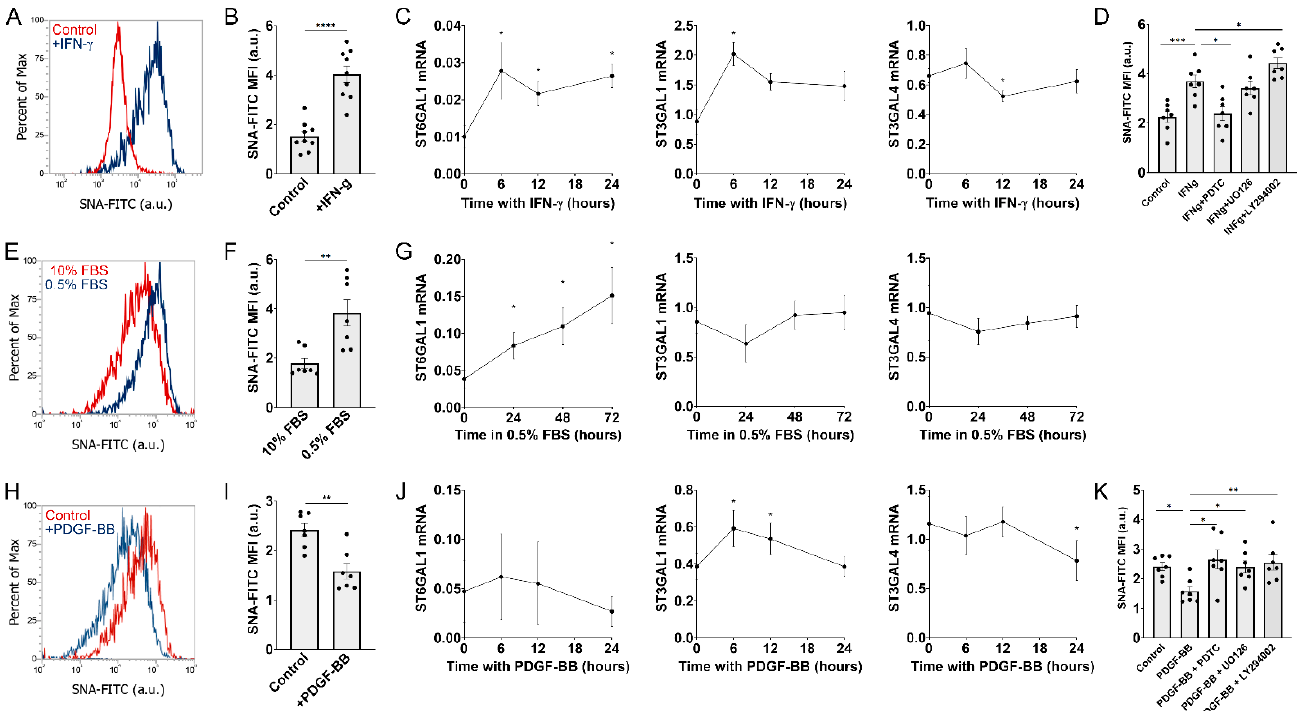
Figure 1. IFN- γ , 0.5%FBS and PDGF-BB modulate sialylations and expression of sialyltransferases. MSCs were cultured for 2 days with either IFN- γ (50 ng/mL), with low fetal bovine serum (0.5% FBS) or PDGF-BB (10 ng/mL) and stained using the lectin SNA, coupled to FITC. ( A , E , H ) show representative histogram plots, while ( B , F , I ) show quantification of the mean fluorescent intensities, with each dot representing a biological replicate (i.e., MSCs derived from a different donor). ( C , G , J ) show mRNA levels of ST6Gal1, ST3Gal1 and ST3Gal4, relative to GAPDH x 1000 (n = 4–5). Differences are calculated in comparison to time 0. ( D , K ) show mean fluorescent intensity of cells treated with either IFN- γ or PDGF-BB and specific inhibitors. MFI: Mean Fluorescence Intensity. a.u.: arbitrary units. * p < 0.05; ** p < 0.005; *** p < 0.0005; and **** p < 0.00005 as calculated using t -test or 1-way ANOVA.